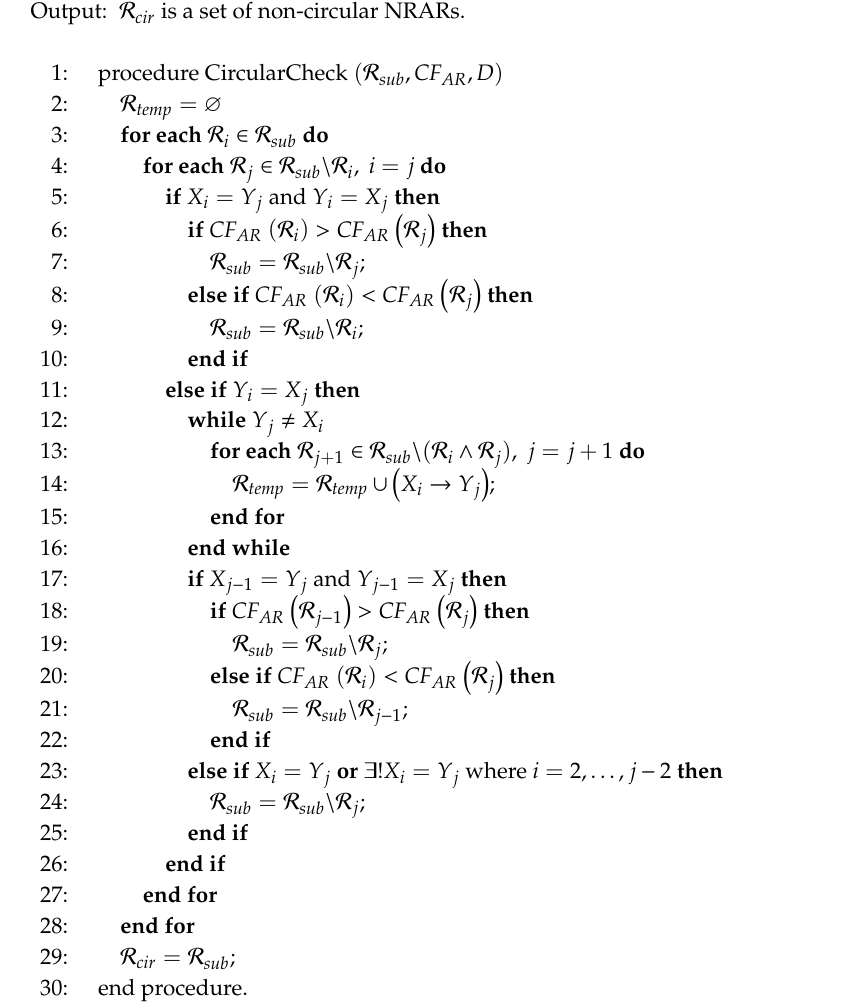
Algorithm 3 Building Non-circular